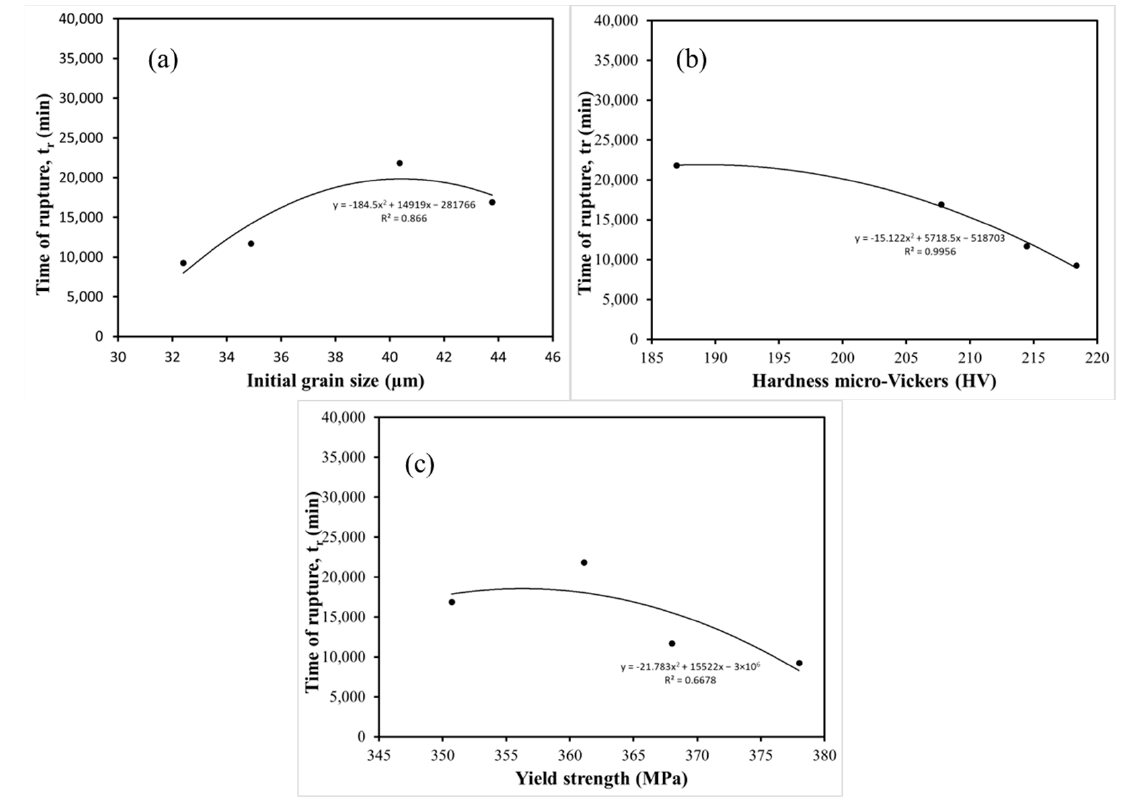
Figure 16. The relationship of time of rupture to ( a ) initial grain size; ( b ) micro-Vickers hardness; ( c ) yield strength.